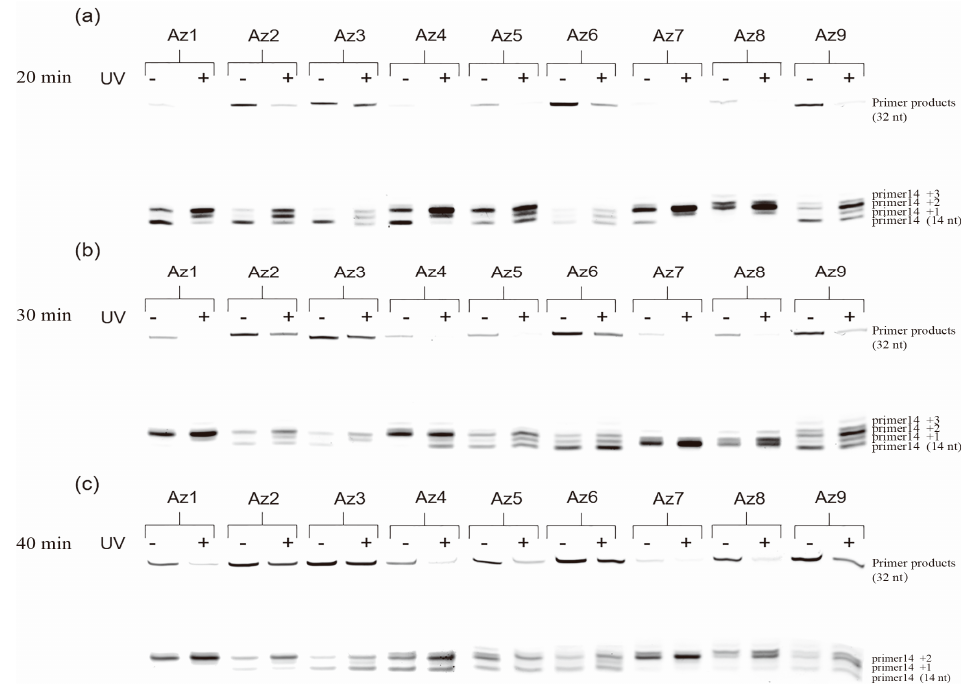
Figure 3. Denaturing PAGE (20%) of photomodulation of the primer extension reactions catalyzed by 1 U Taq DNA polymerase in the presence of 1 µ M FAM-primer and Tem32 template, 1 µ M azobenzene-linked asODNs and all four dNTPs (0.4 mM each) in 20 µ L Taq buffer without ( − ) or with (+) UV irradiation at 37 ◦ C. Polymerization reactions were incubated for ( a ) 20 min, ( b ) 30 min and ( c ) 40 min before terminating with EDTA.